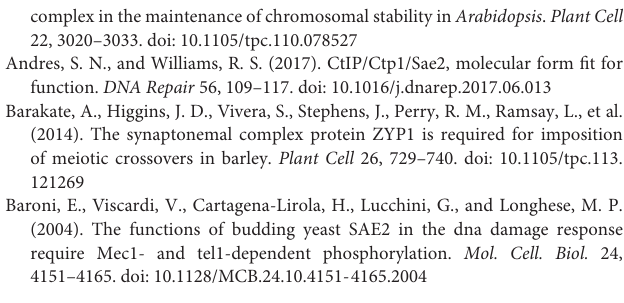
FIGURE S1 | Protein sequence alignment of ZmCom1 and OsCom1. The proteins were aligned with CLUSTALW and image was made by MultAlign (http://multalin.toulouse.inra.fr/multalin/). Conserved ( > 90% conservation) amino acid residues are red, variable ( < 50% conservation) are blue. Species abbreviation: Zm, Zea mays ; Os, Oryza sativa . The red and green underlines indicate the conserved SMC-N and SAE2 domain, respectively. FIGURE S2 | Neighbor-joining phylogeny reconstruction of Com1 homologs from different plant species. Numbers next to branches indicate posterior probability values. The scale indicates number of substitutions per site. Protein sequences were aligned using ClustalX (Jeanmougin et al., 1998) and phylogeny reconstruction was conducted using the online software (http://www.phylogeny.fr/, Dereeper et al., 2010). Species abbreviation: Zm, Zea mays ; Os, Oryza sativa ; Sb, Sorghum bi color; At, Arabidopsis thaliana ; Bn, Brassica napa ; Bd, Brachypodium distachyon ; Hv, Hordeum vulgare ; Ta, Triticum aestivum ; Cs, Camelina sativa ; Rs, Raphanus sativus ; Es, Eutrema salsugineum . FIGURE S3 | Morphological comparison between wild type and Zmcom1-2 mutant. (A) Morphological comparison of mature seeds between wild type and Zmcom1-2 mutant. (B) Growth-curve of plant height in wild type and Zmcom1-2 mutant plants. Values are means of 10 individual plants. (C) Comparison of Morphological comparison of mature plants between wild type and Zmcom1-2 mutant. (D) Comparison of a wild type tassel and a Zmcom1-2 tassel at the flowering stage. (E) Comparison of a wild type ear and a Zmcom1-2 ear. (F) Normal pollen grains of the wild type. Scale bar = 100 µ m. (G) Complete sterile pollen grains of the Zmcom1-2 plant. Scale bar = 100 µ m. FIGURE S4 | PCR-based genotyping of seeds from self-propagated heterozygous Zmcom1 plants. (A) F2 progeny of Zmcom1-1 . 1–6: Seeds with normal size; 7–24: Seeds with small size. (B) F2 progeny of Zmcom1-2 . 25–30: Seeds with normal size; 31–48: Seeds with small size. FIGURE S5 | Male meiosis in Zmcom1-2 . (A) Leptotene; (B) Zygotene; (C) Pachytene; (D) Diakinesis; (E) Metaphase I; (G) Anaphase I; (F) Dyad; (H) Tetrads. The red arrows pointed out the chromosomal fragments and abnormal bridges. Scale bars = 10 µ m. FIGURE S6 | The defective bouquet formation and homologous pairing in Zmcom1-2. (A) Bouquet formation analysis using FISH with the telomere-specific pAtT4 probe in Zmcom1-2 ( n = 41). Scale bars = 10 µ m. (B) Homologous pairing analysis using FISH with 5S rDNA probe in in Zmcom1-2 ( n = 27). Scale bars = 10 µ m. FIGURE S7 | Immunolocalization of ASY1, DSY2, and ZYP1 antibodies in Zmcom1-2 . ASY1 ( A , n = 23), DSY2 ( B , n = 33), and ZYP1 ( C , n = 37) on prophase I chromosomes in Zmcom1-2 . Scale bars = 10 µ m. FIGURE S8 | Immunolocalization of RAD51 antibodies in Zmcom1-2 meioctyes ( n = 36) at zygotene. DAPI staining is used to indicate the chromosomes. Scale bars = 10 µ m. FIGURE S9 | Genome instability in mitotic cells from Zmcom1-2 plants. (A) Prophase; (B) Metaphase; (C) Anaphase. Lagging chromosome fragments and anaphase bridges were highlighted by red arrows. Scale bars = 10 µ m. TABLE S1 | Primers used in this study. TABLE S2 | Segregation ratio of small seeds versus normal